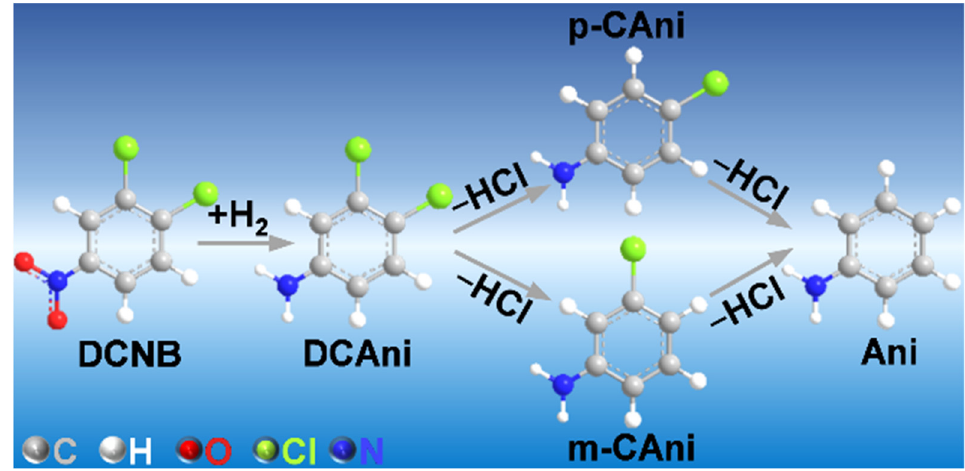
Figure 1. The reaction pathways for the hydrogenation of 1,2-dichloro-4-nitrobenzene (DCNB) to 3,4-dichloroaniline (DCAni). Other hydrodechlorinated by-products (m- and p-chloranilines and aniline, abbreviated as m- and p-CAni and Ani, respectively) can be formed by deep hydrogenation.